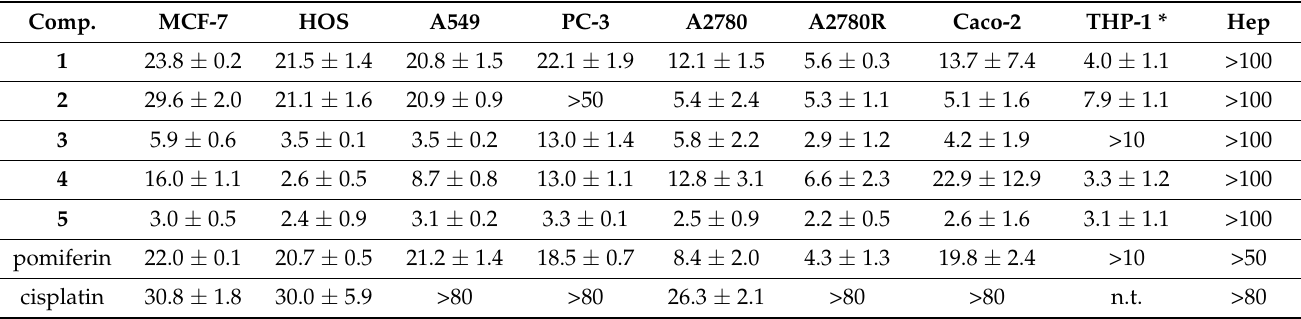
Table 1. The results of in vitro cytotoxicity testing (expressed as mean IC 50 values with standard deviations (SD) calculated out of at least three independent experiments in µ M) of complexes 1 – 5 on the following human cancer cell lines: breast adenocarcinoma (MCF-7), osteosarcoma (HOS), lung adenocarcinoma (A549), prostate adenocarcinoma (PC-3), ovarian carcinoma (A2780), ovarian carcinoma resistant to cisplatin (A2780R), colorectal carcinoma (Caco-2), and THP-1, and toxicity against primary culture of human hepatocytes (Hep). The cytotoxicity of the complexes is compared to the free ligand HL (pomiferin) and platinum-containing chemotherapeutic drug cisplatin.